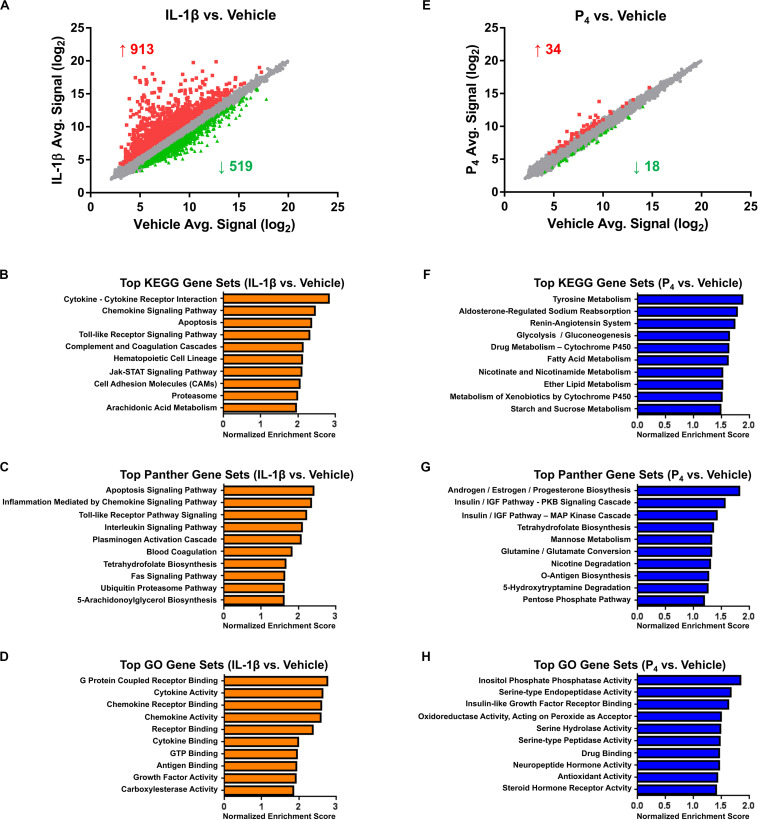
Microarray and bioinformatics analysis of differentially expressed genes in cervical stromal fibroblasts stimulated with IL-1β (0.2 ng/ml) or P4 (10–7 M) for hrs. Cells were primed with 17β-E2 (10–8 M) to induce progesterone receptors -A and -B and then challenged for 4 hrs with IL-1β (A–D) or P4 for 4 h (after a 24-h preincubation with the steroid) (E–H), total RNA isolated and quantified and differential gene expression by microarray analysis. The normalized data are expressed as mean signal intensity (log2) and are from three separate experiments carried out in duplicate (A,E). Bioinformatics analysis of differentially expressed transcripts using KEGG (B,F), Panther (C,G) and GO (D,H) algorithms.